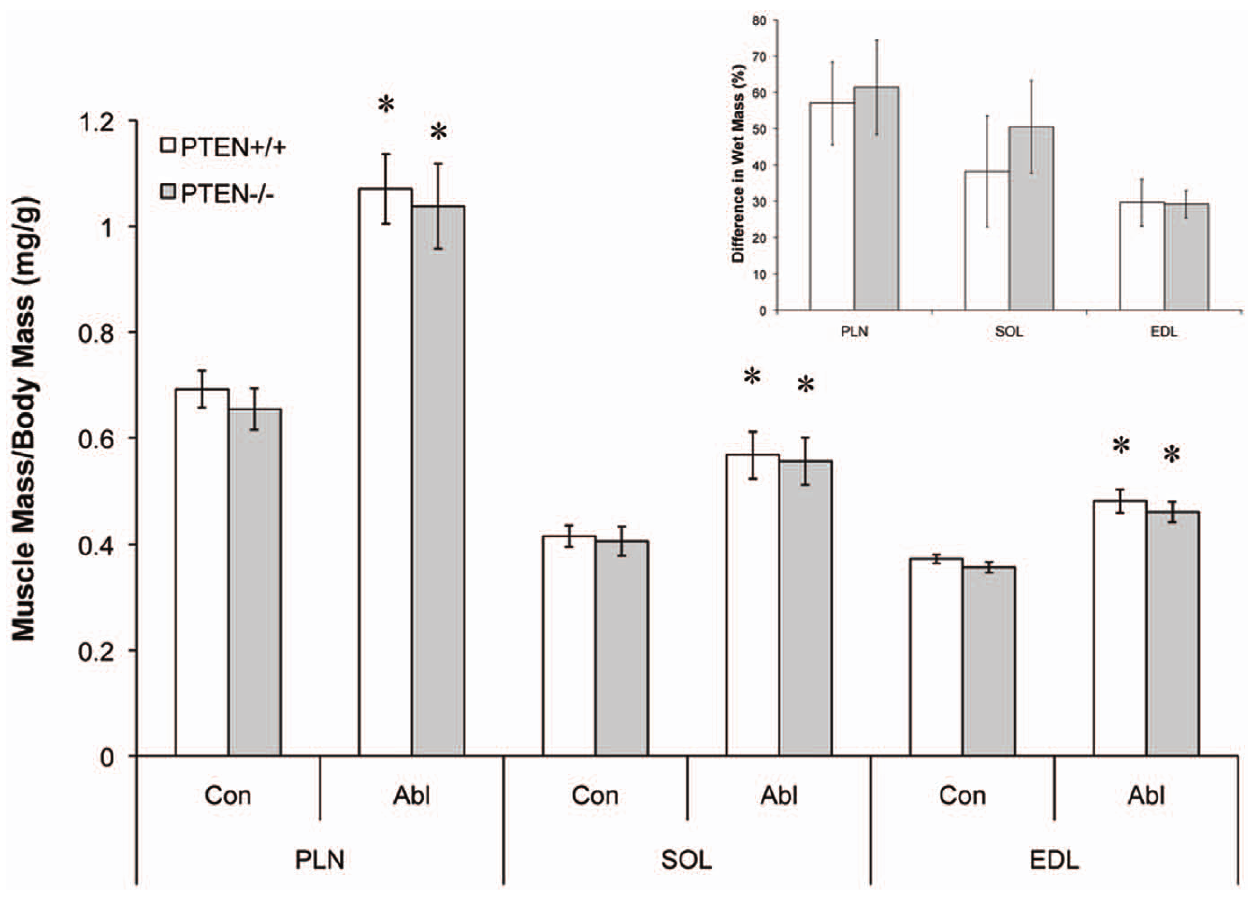
Figure 4. PTEN knockout in striated muscle does not alter muscle hypertrophy in response to overload. The plantaris (PLN) and soleus (SOL) muscles were overloaded by ablation of the gastrocnemius muscle for 10 days. In a separate group of animals the extensor digitorum longus (EDL) muscle was overloaded by removal of the tibialis anterior muscle for 4 weeks. Data presented are mean muscle mass from the control (Con) and ablated (Abl) legs divided by the body mass of the animals for n=6 animals. * indicates significantly larger muscle mass than the controls.